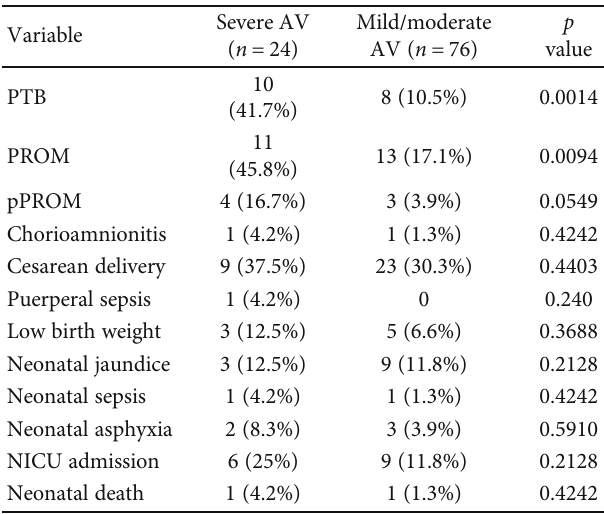
Table 4: Comparison of maternal and neonatal outcomes according to the severity of aerobic